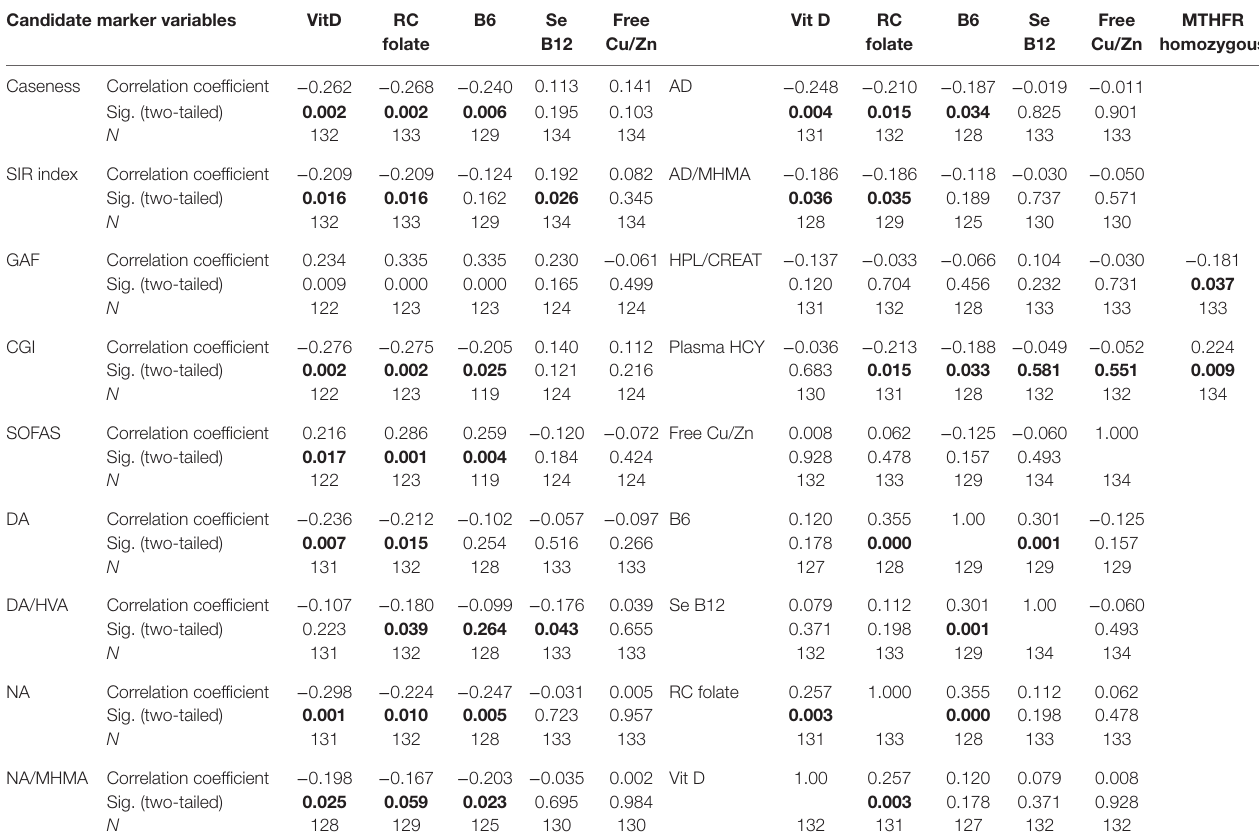
TaBle 2 | Total sample correlation analysis for biochemical